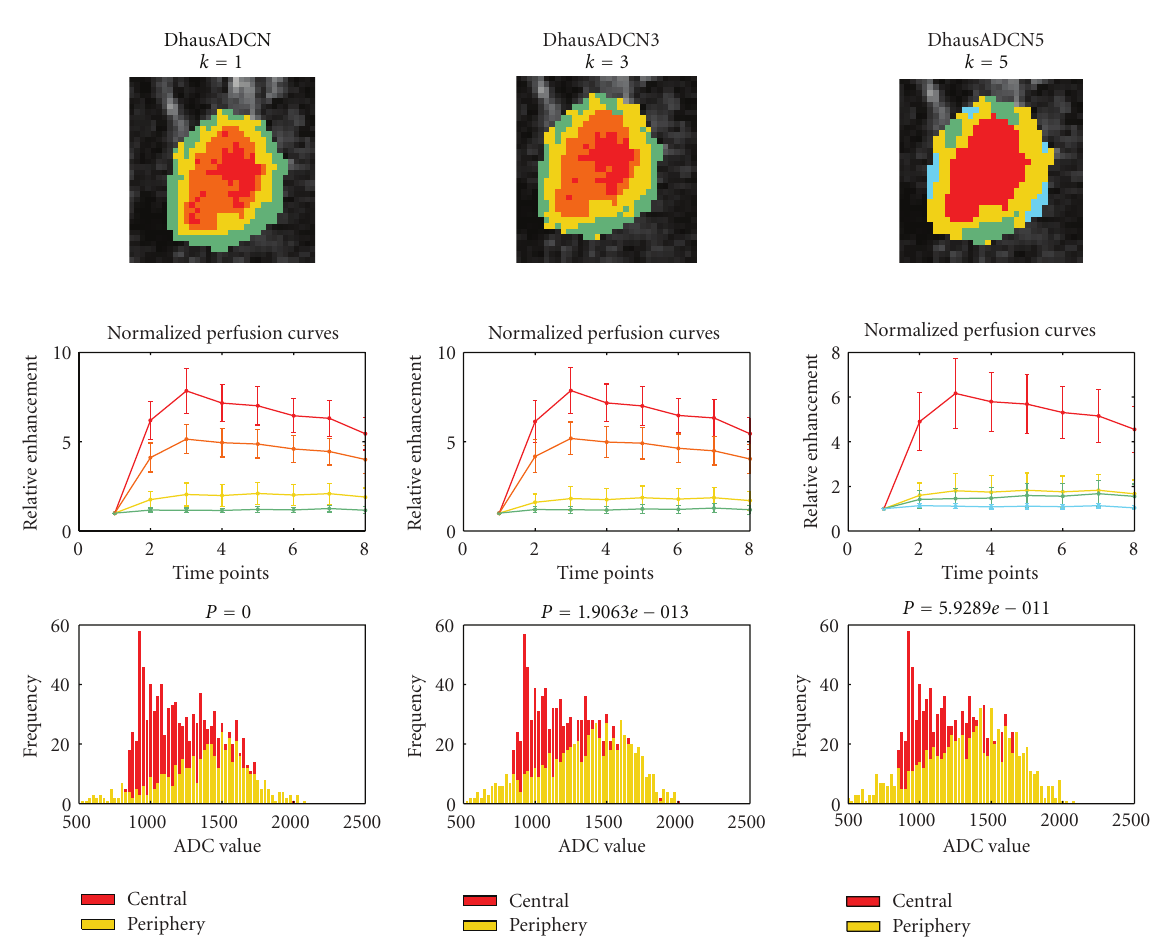
Figure 4: Clustering results using di ff erent values for the tuning parameter k ADC (1, 3, and